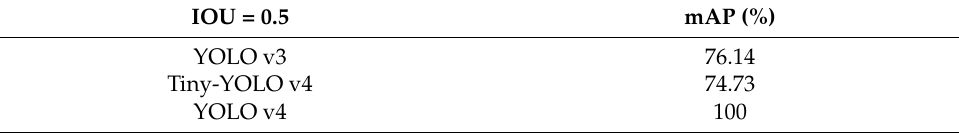
Table 5. Performance of the compared algorithms when the IOU value was